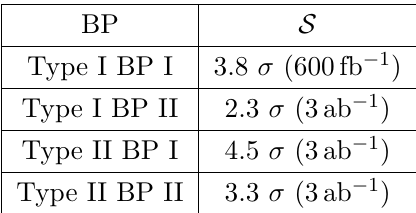
Table 6 . Signal signi(cid:12)cance for the benchmark points at 14 TeV in the VBF channel.